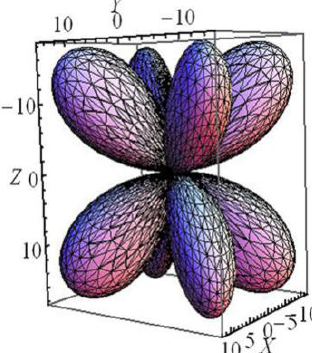
Figure 3. The orientation dependence of piezoelectric coefficient for sillenite